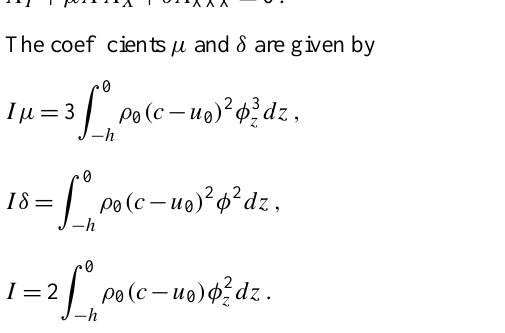
upper panel in Fig. 2. For δµ 1 > 0 there are two